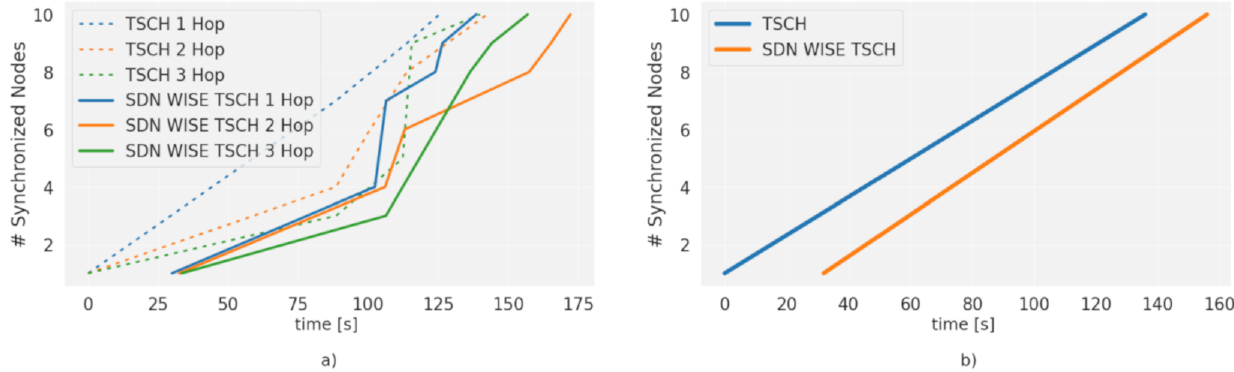
Figure 8. Software Defined Networking solution for Wireless Sensor Networks (SDN-WISE) TSCH convergence time with TSCH synchronization; ( a ) Convergence time; ( b ) Trend Convergence